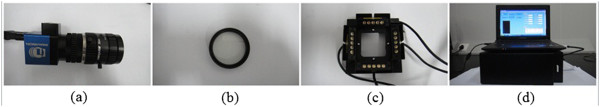
Hardware units of the device. (a) CCD image sensor. (b) UV filter. (c) Excitation light source. (d) Integrated instrument.